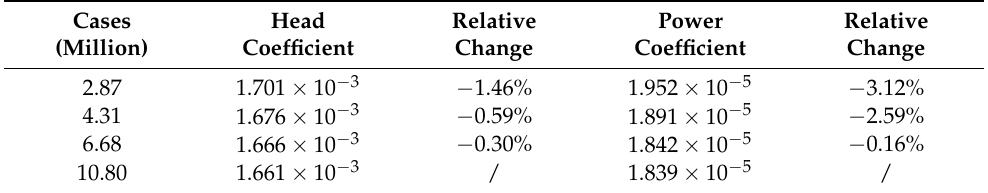
Table 3. Validation of grid independence.